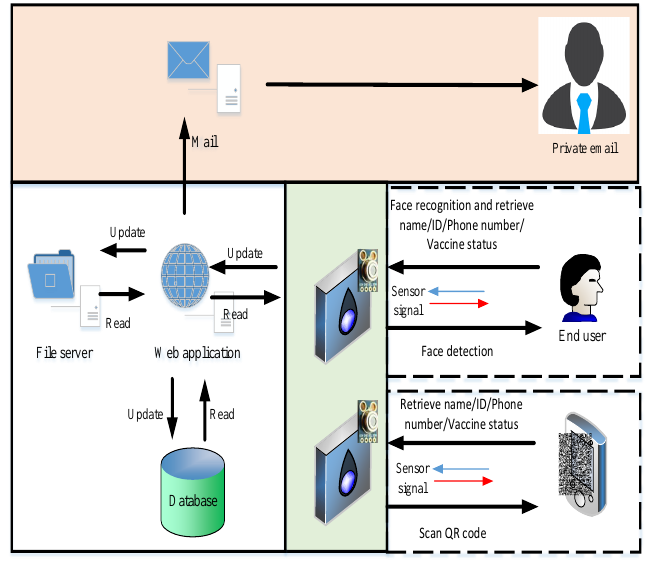
Figure 3. System design of the IoT-based intelligent